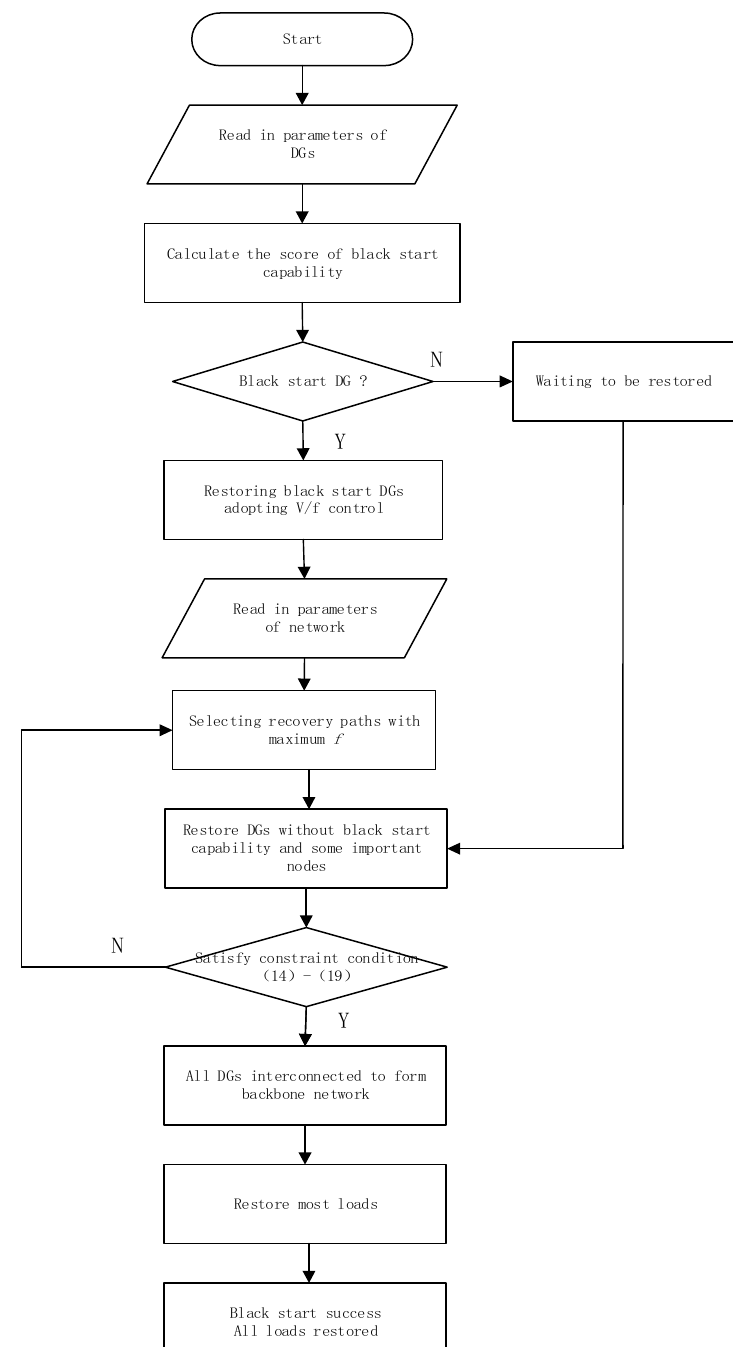
Figure 1. Flow chart of parallel restoration strategy.